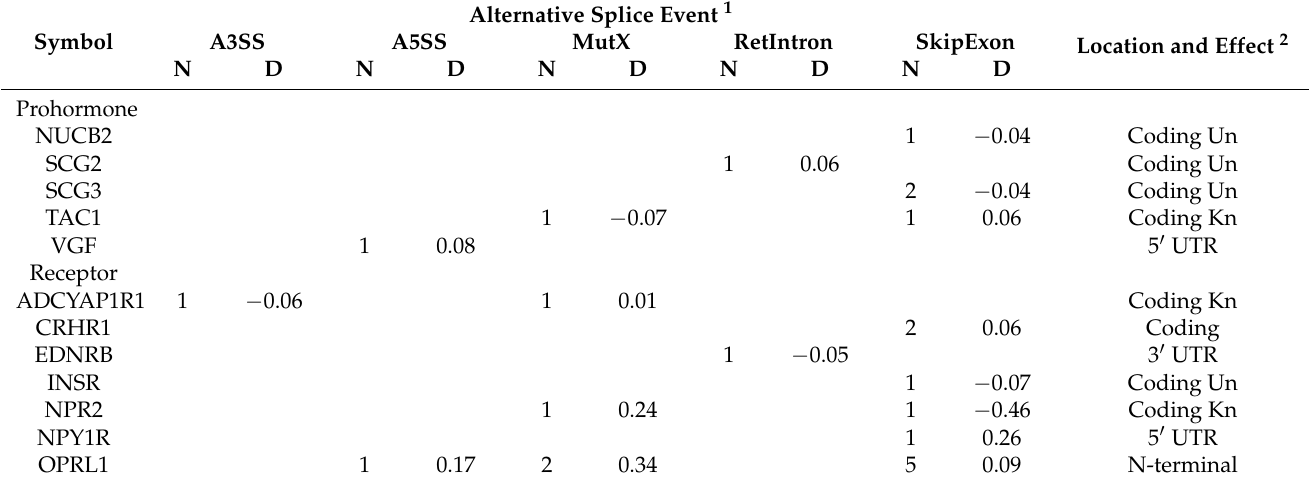
Table 6. Neuropeptide prohormone and receptor genes presenting significant (FDR-adjusted p -value < 0.1) alternative spliced events between nucleus accumbens (NAc) and trigeminal gan- glia